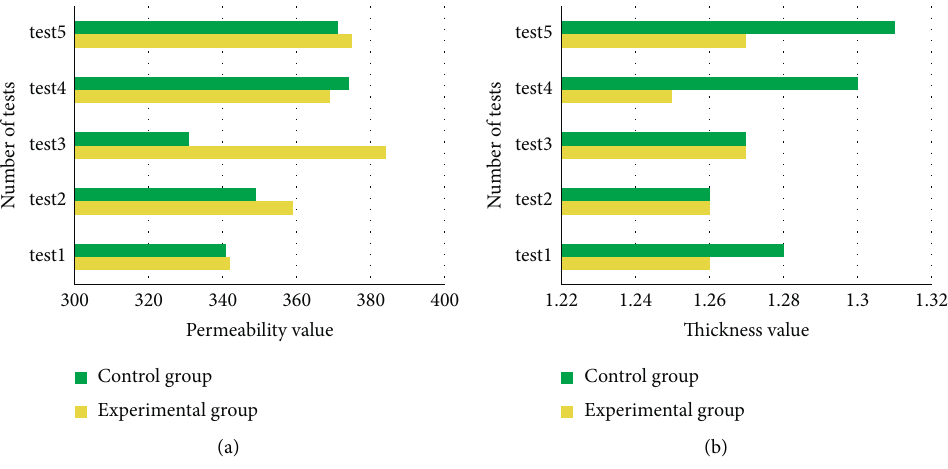
Figure 9: Fabric performance test. (a) The results of the fabric air permeability test. (b) Fabric thickness test